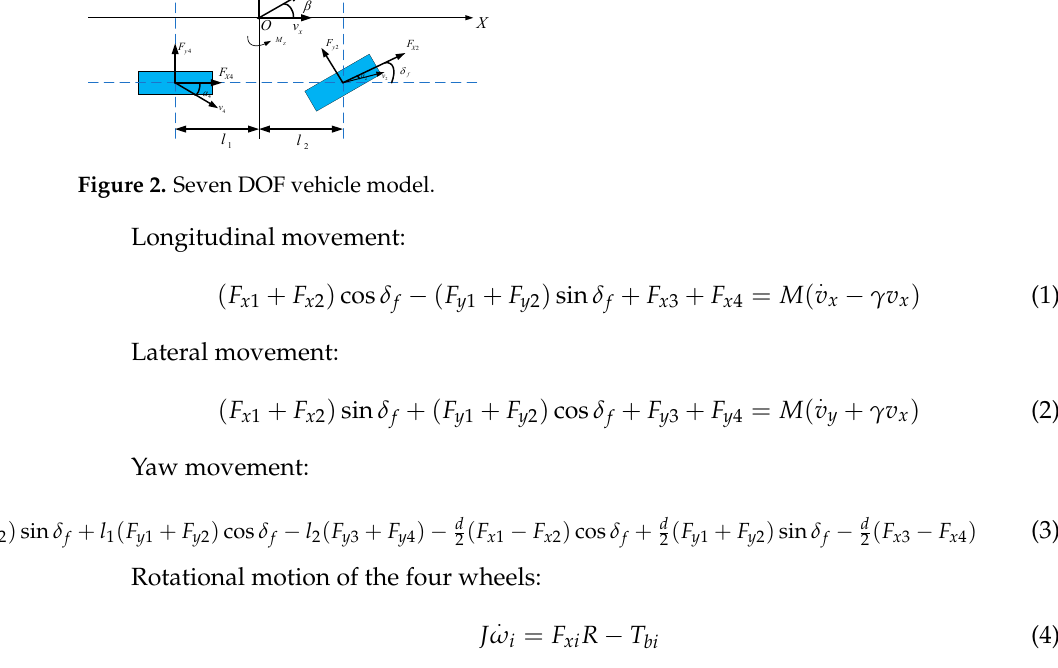
are longitudinal force, lateral force, wheel slip angle, and wheel speed, respectively, where ( i = 1, 2, 3, 4 ) represent the left front wheel, the right wheel speed, respectively, where ( 1,2,3,4) i = represent the left front wheel, the right front front wheel, and the left rear wheel, respectively. δ f is the turning angle of the front wheel wheel, and the left rear wheel, respectively. is the turning angle of the front wheel of is the yaw moment v is the longitudinal x is the lateral speed of the vehicle, and are the front l and rear wheelbases, respectively. 1 2 l and rear wheelbases, respectively.